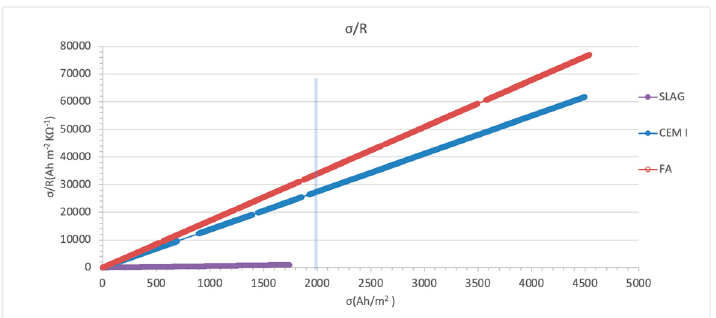
Figure 4. Charged density values normalized using the initial mortar resistivity ( σ / R ) represented vs. the accumulated charged density ( σ ).